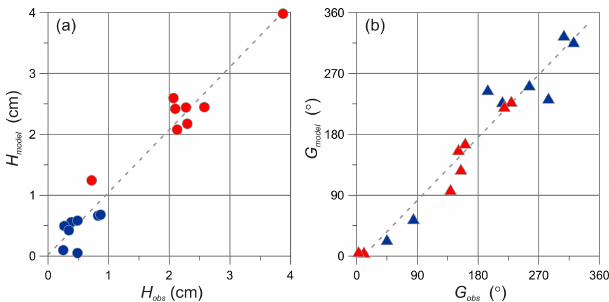
Figure 2. Comparisons of (a) amplitudes and (b) phase lags of har- monics M 2 (red) and K 1 (blue) estimated by the numerical mod- elling ( H model and G model ) and from tide gauge observations ( H obs and G obs